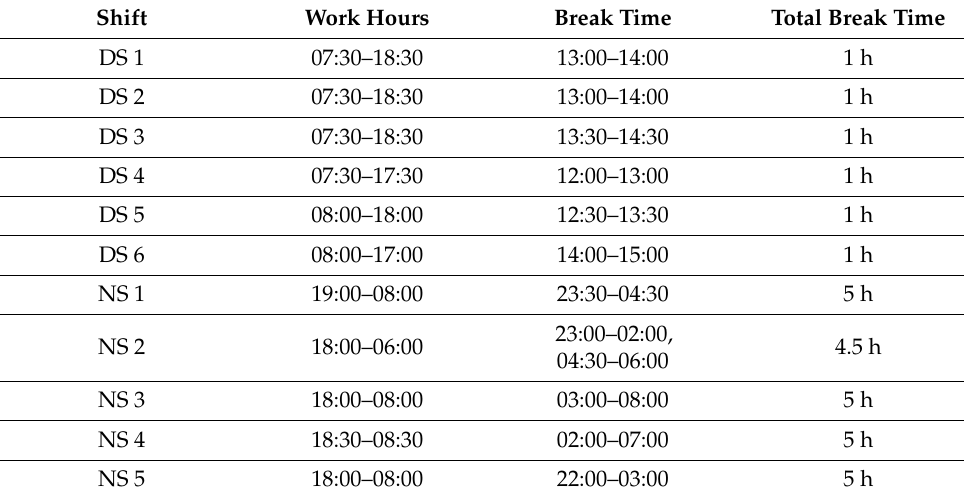
Table 1. Work schedule in day shifts (DS) and in night shift